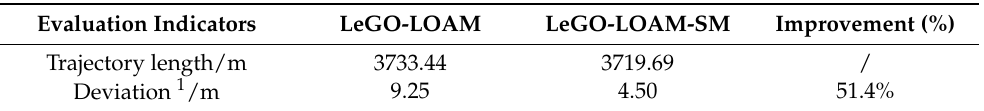
Table 1. The estimated length and its deviation of the KITTI dataset 00 sequence trajectory by Table 1. KITTI dataset 00 sequence trajectory length and its deviation estimated by LeGO-LOAM LeGO-LOAM and and LeGO-LOAM-SM.